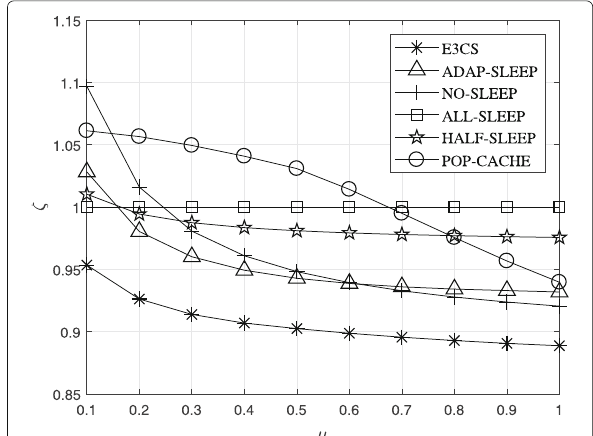
Fig. 6 Effect of the download rate μ between the content server and